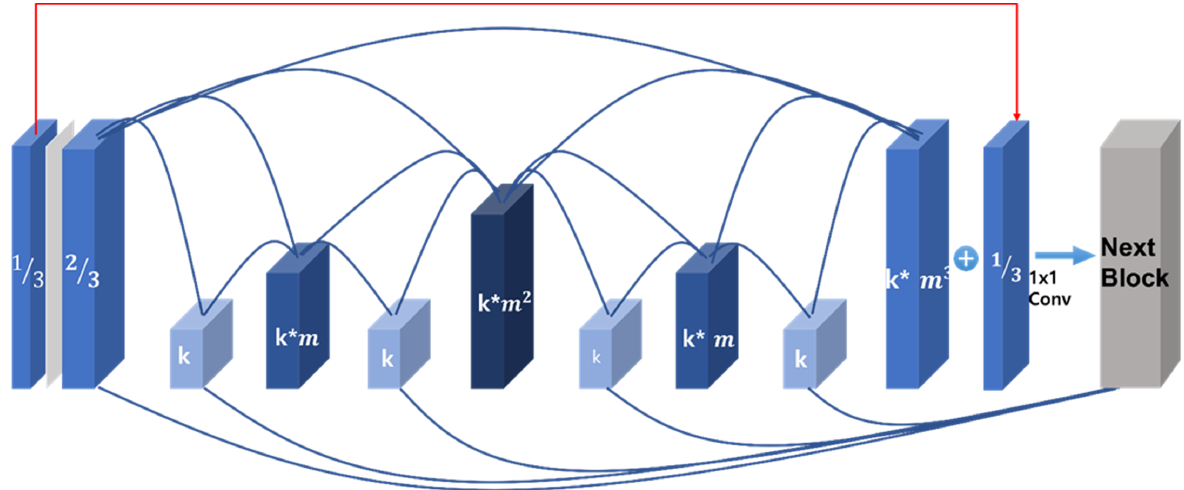
Figure 2. The proposed CSPHarDNet structure.